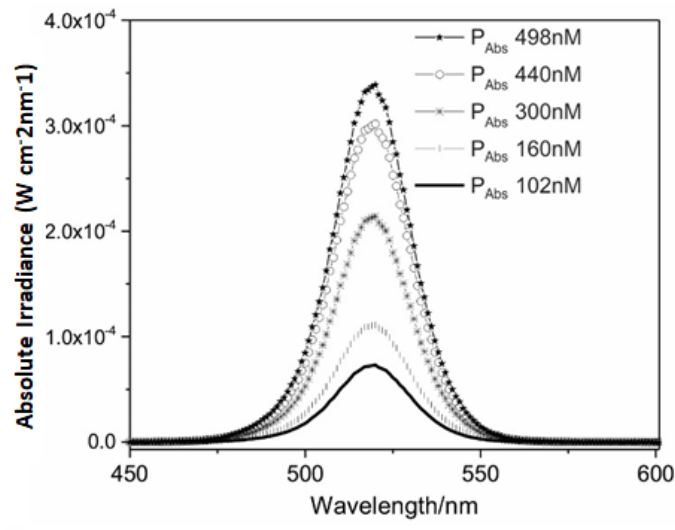
Figure 1. Spectra of light emitted by light-emitting diode (LED) (P LED Emitted ) and power absorbed by eosin (P Abs ) in different concentrations ( 498 nM; 440 nM; 300 nM; 160 nM; and 102 nM).